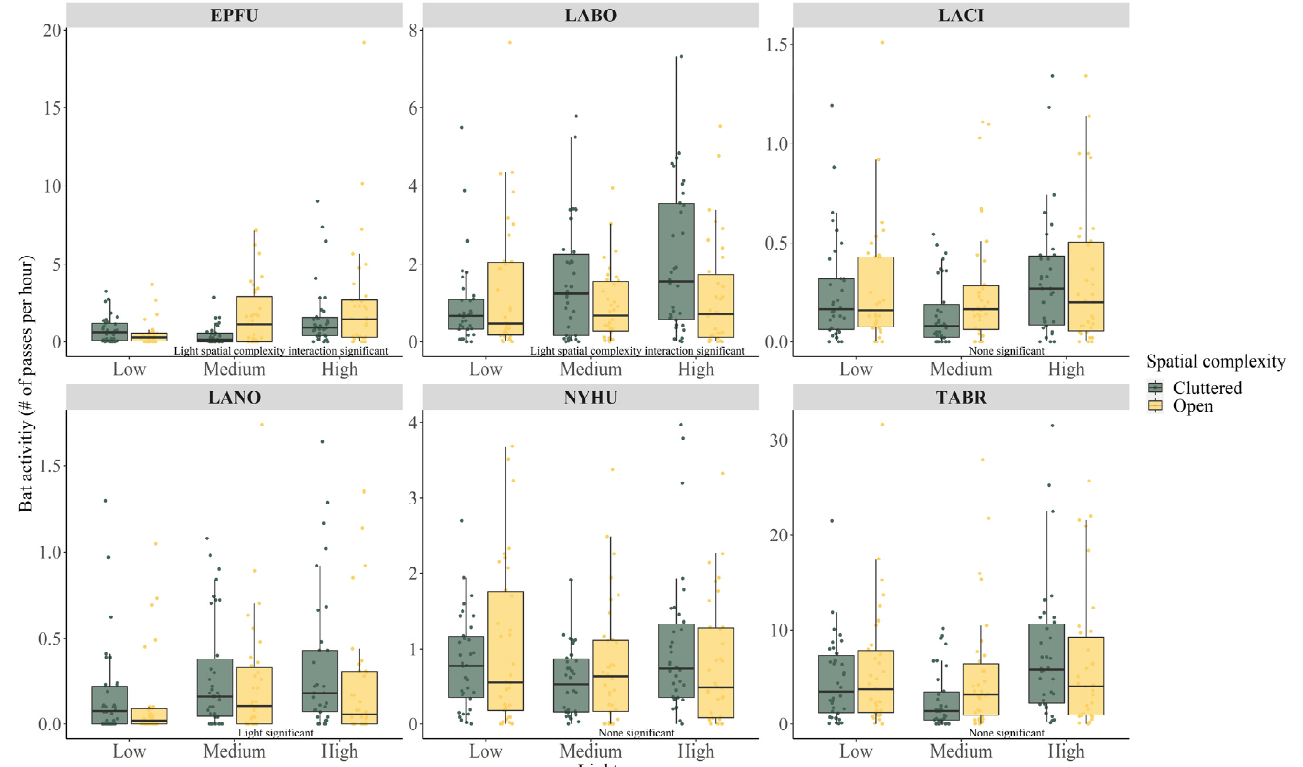
Figure 2. Boxplots (25th, 50th, 75th percentiles) and raw data point of species-specific bat activity at sites of varying ALAN levels and spatial complexity. Independent variable significance is annotated in the graph. Species abbreviations: big brown bat ( Eptesicus fuscus , EPFU), eastern red bat ( Lasiurus borealis , LABO), hoary bat ( Lasiurus cinereus , LACI), silver-haired bat ( Lasionycteris noctivagans , LANO), cave myotis ( Myotis velifer , MYVE), evening bat ( Nycticeius humeralis , NYHU), tricolored bat ( Perimyotis subflavus , PESU) and Mexican free-tailed bat ( Tadarida brasiliensis , TABR). Independent variable significance is annotated in the graph.